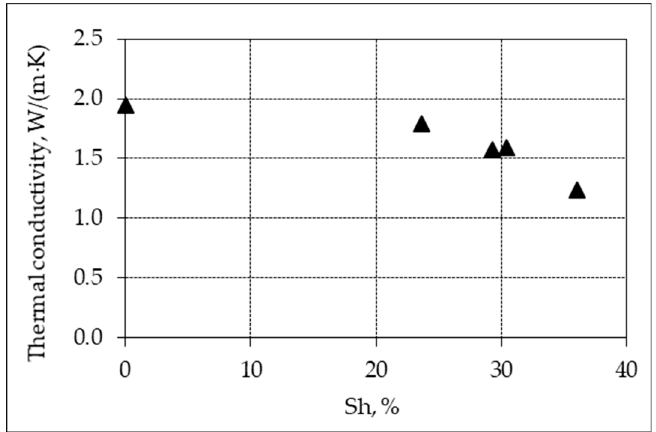
Figure 4. Thermal conductivity as a function of hydrate saturation in frozen silty sand ( W = 17%), at P = 0.1 MPa and t = − 6 ± 1 ° C.